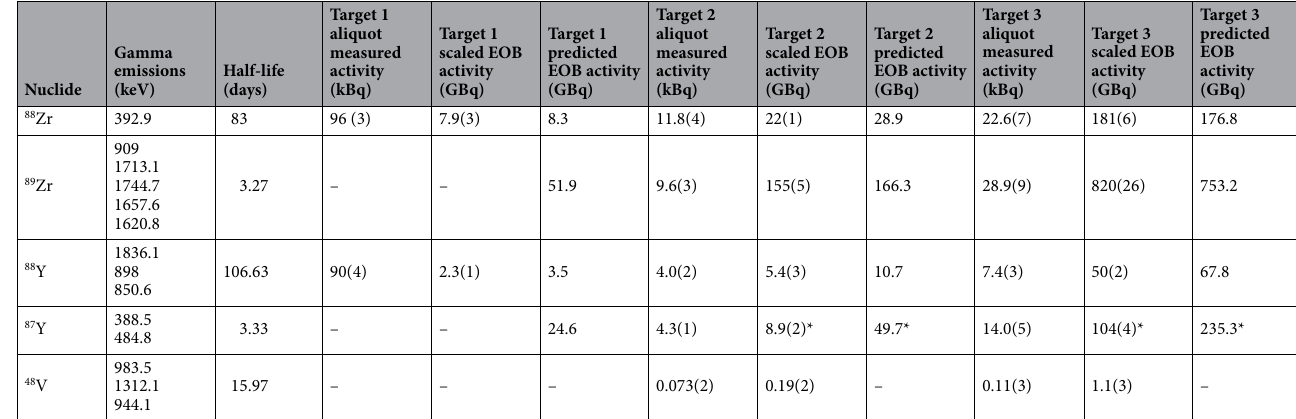
Table 3. Measured, scaled and model predicted End of Bombardment (EOB) activities of radionuclides in dissolved Y metal targets. *Listed measured and predicted activities of 87 Y are at the time of